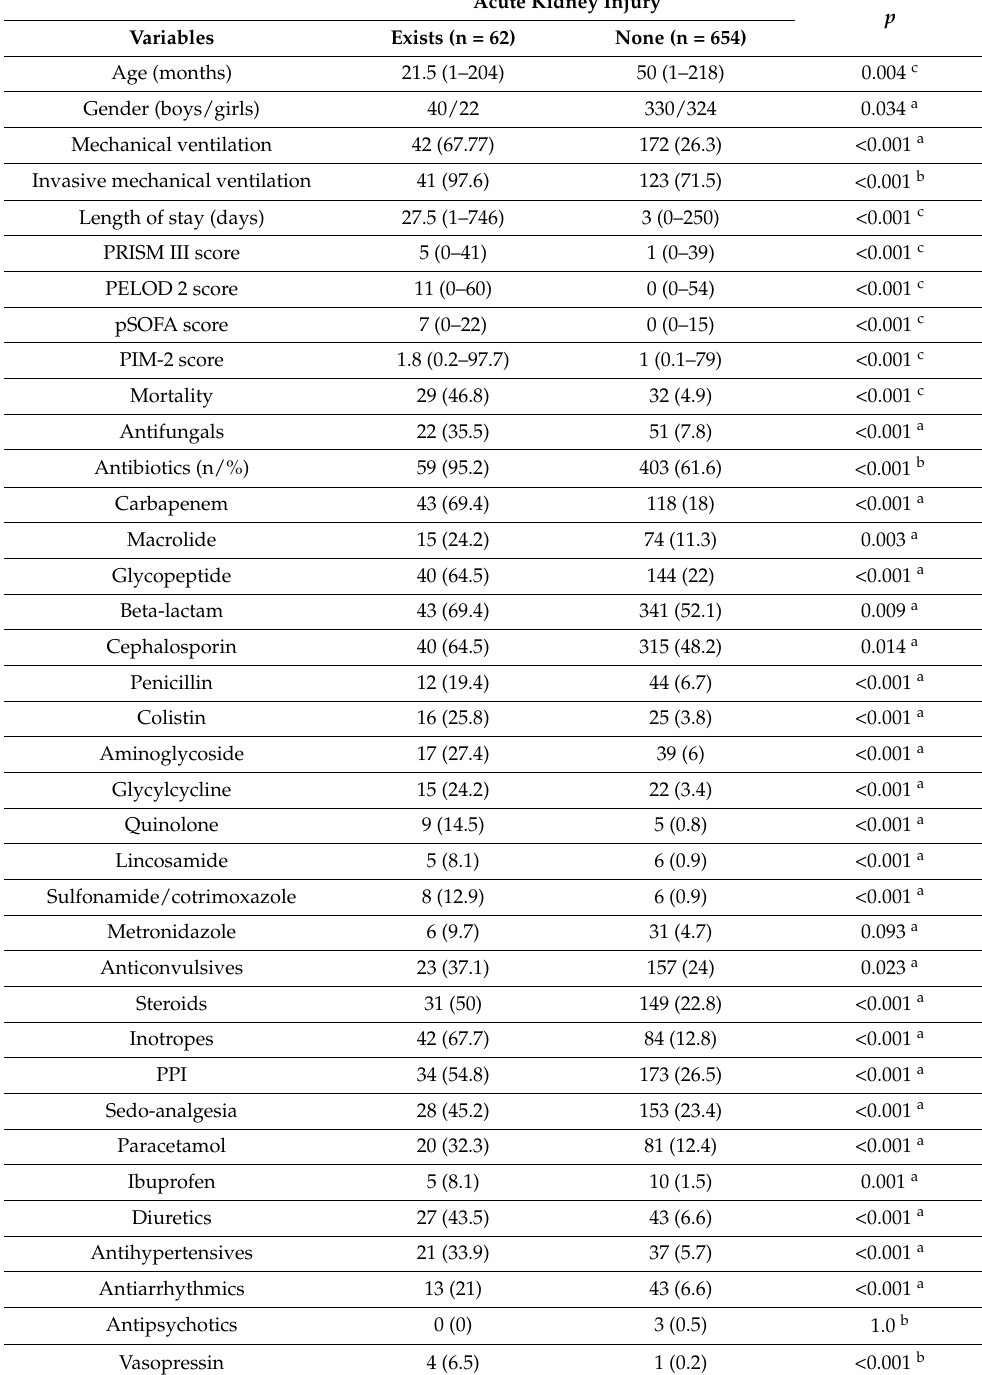
Table 1. Demographic and clinical factors, medications, and interventions in pediatric intensive care among children with or without acute kidney